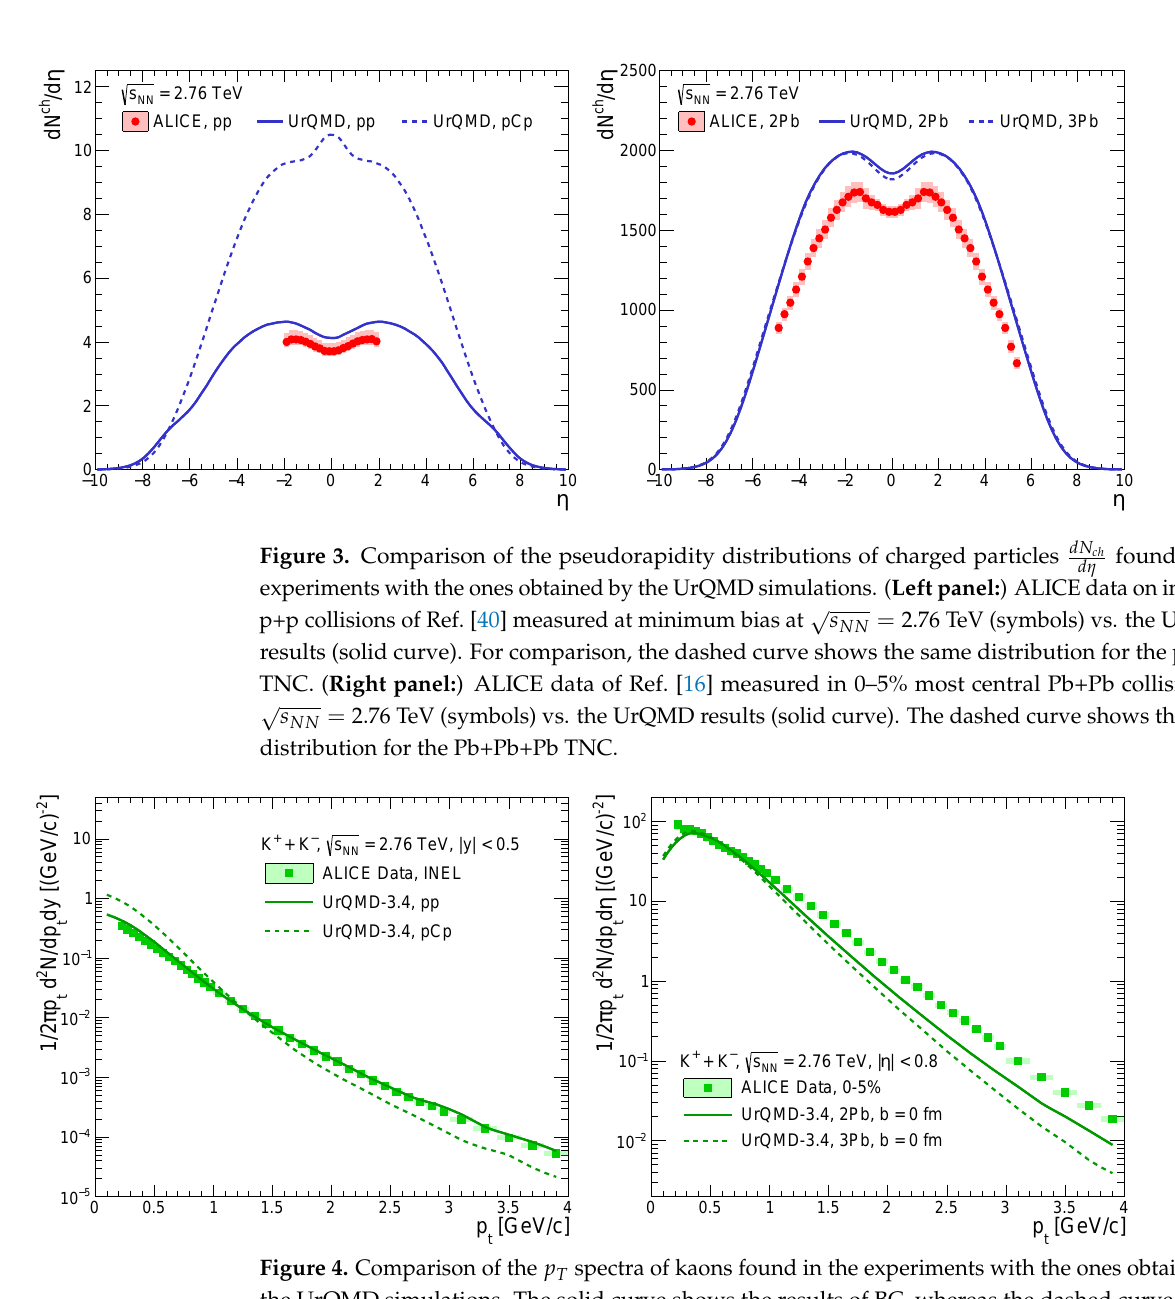
Figure 4. Comparison of the p T spectra of kaons found in the experiments with the ones obtained by the UrQMD simulations. The solid curve shows the results of BC, whereas the dashed curve shows the results for TNC. ( Left panel: ) ALICE data on inelastic p+p collisions of Refs. [41–43] measured at minimum bias (symbols) vs. the UrQMD results for the p+p BC and for the p+C+p TNC. ( Right panel: ) ALICE data of Ref. [16] measured in 0–5% most central Pb+Pb collisions vs. the UrQMD results for the Pb+Pb BC and for the Pb+Pb+Pb